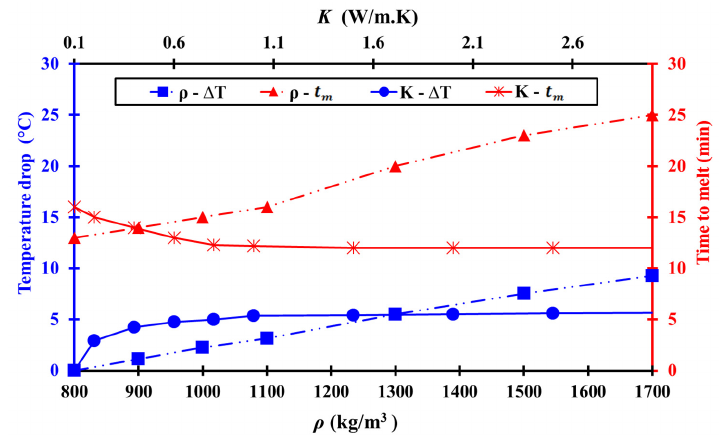
Figure 13. The effects of increasing the thermal conductivity of PCM (Paraffin) on the temperature drop of HS and time for the material to melt